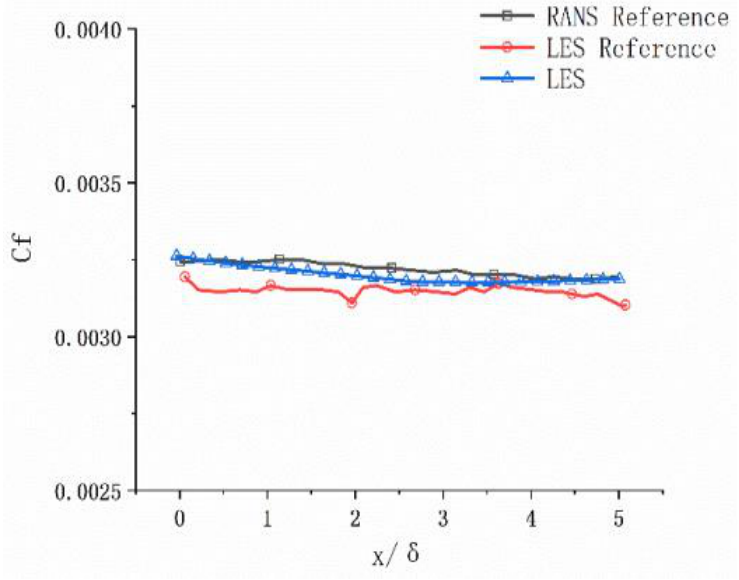
Figure 9. Frictional drag coefficient of smooth plate at 0.1 Ma. Figure 10 is the comparison between the calculated results of the velocity profile of the smooth plate and the results of the literature at 0.1 Ma.